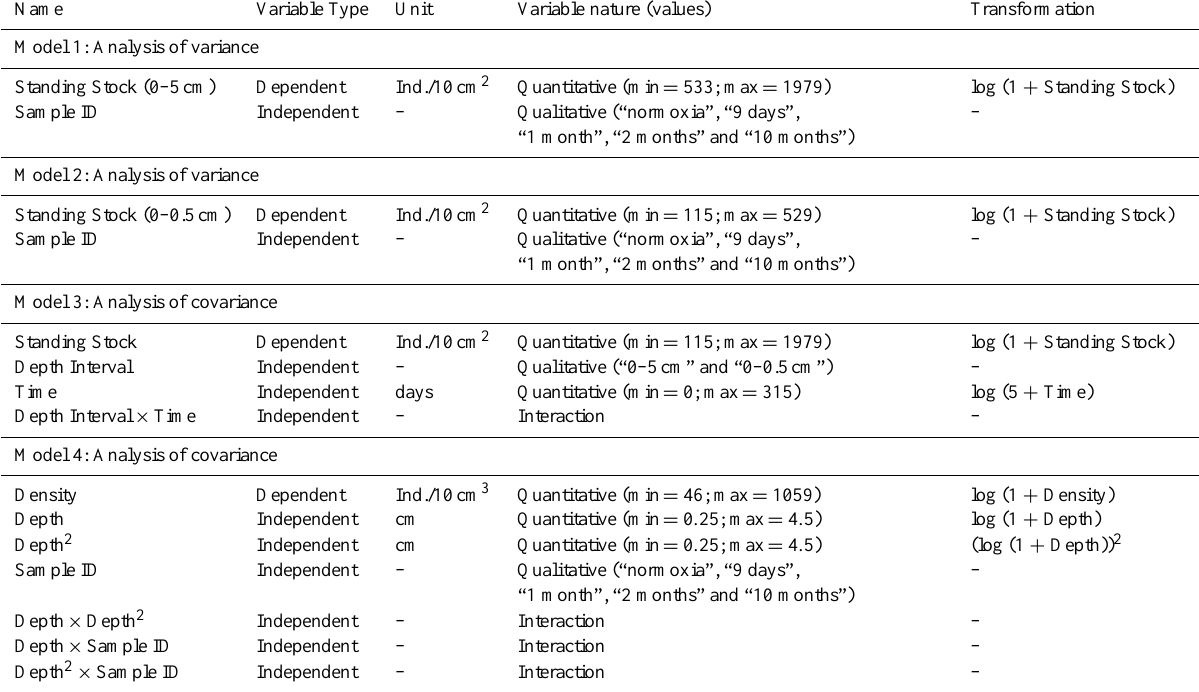
Table 2. Summary of the variables used in each of the three linear models, describing the name of the variable, its type (dependent or inde- pendent), its unit, nature (quantitative or qualitative) and the used transformation. For the quantitative variables the minimum and maximum values of the nontransformed data are presented in brackets, whereas for the qualitative variables the different categories are presented in brackets.